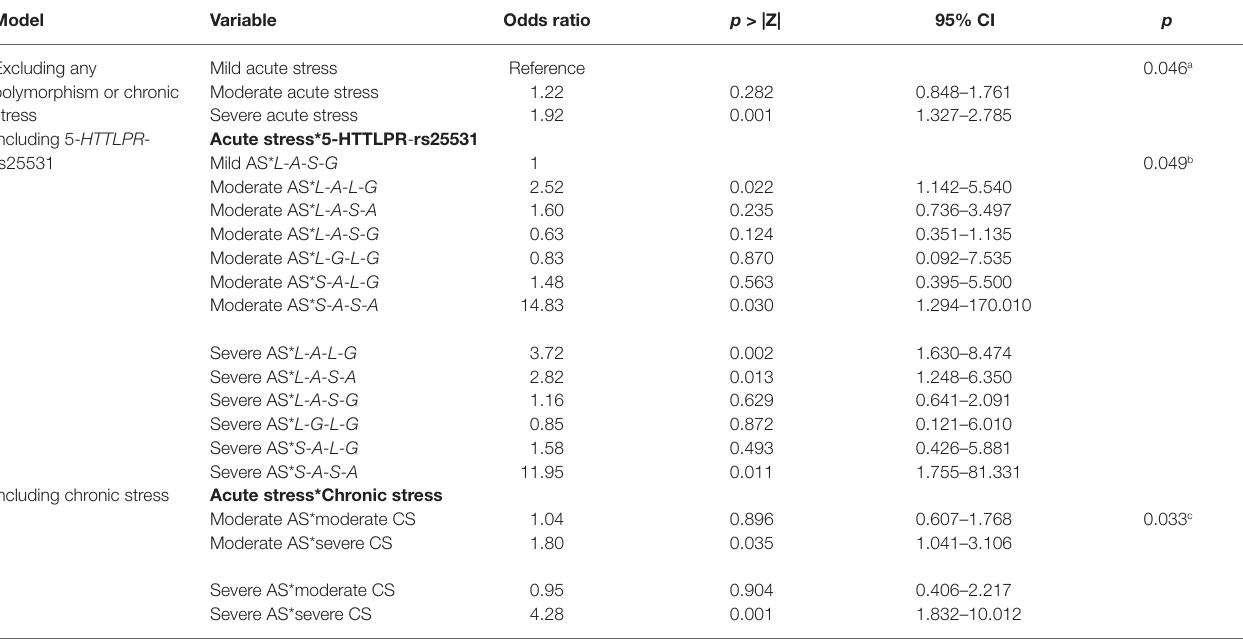
TABLE 5 | Logistic regression analyses for the interaction of acute stress with 5-HTTLPR -rs25531 and chronic stress, respectively, on IMDs. Model Variable Odds ratio p > |Z| 95% CI p Excluding any polymorphism or